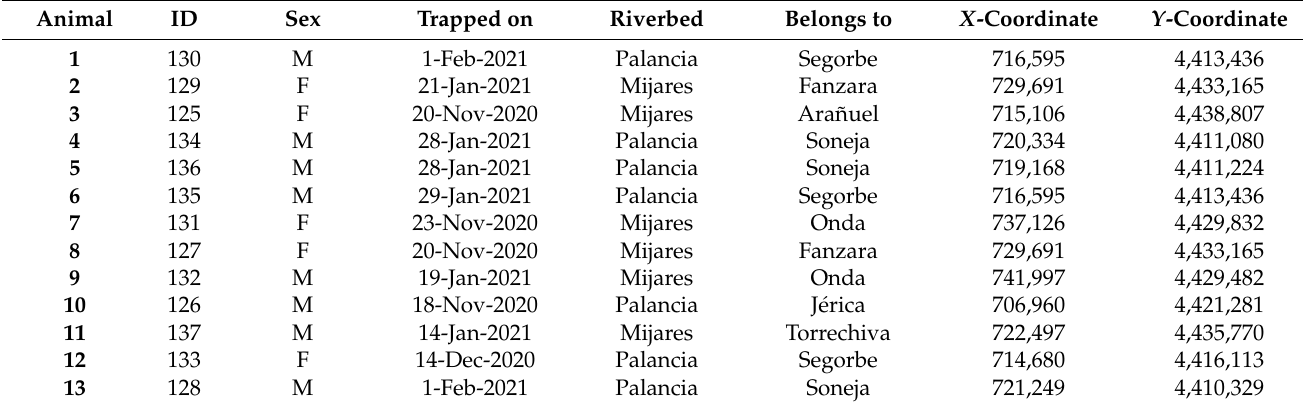
Table 1. Information on the mink herein studied and on their trapping points. The given coordinates are those for the Universal Transverse Mercator (UTM) system of the GPS location of the site at which each animal was trapped. M, male; F,